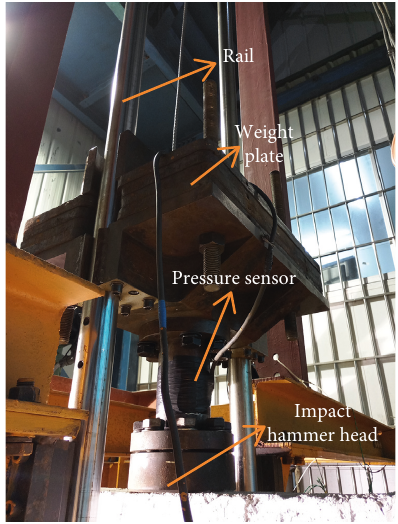
Figure 4: Laser trigger and velocity measuring